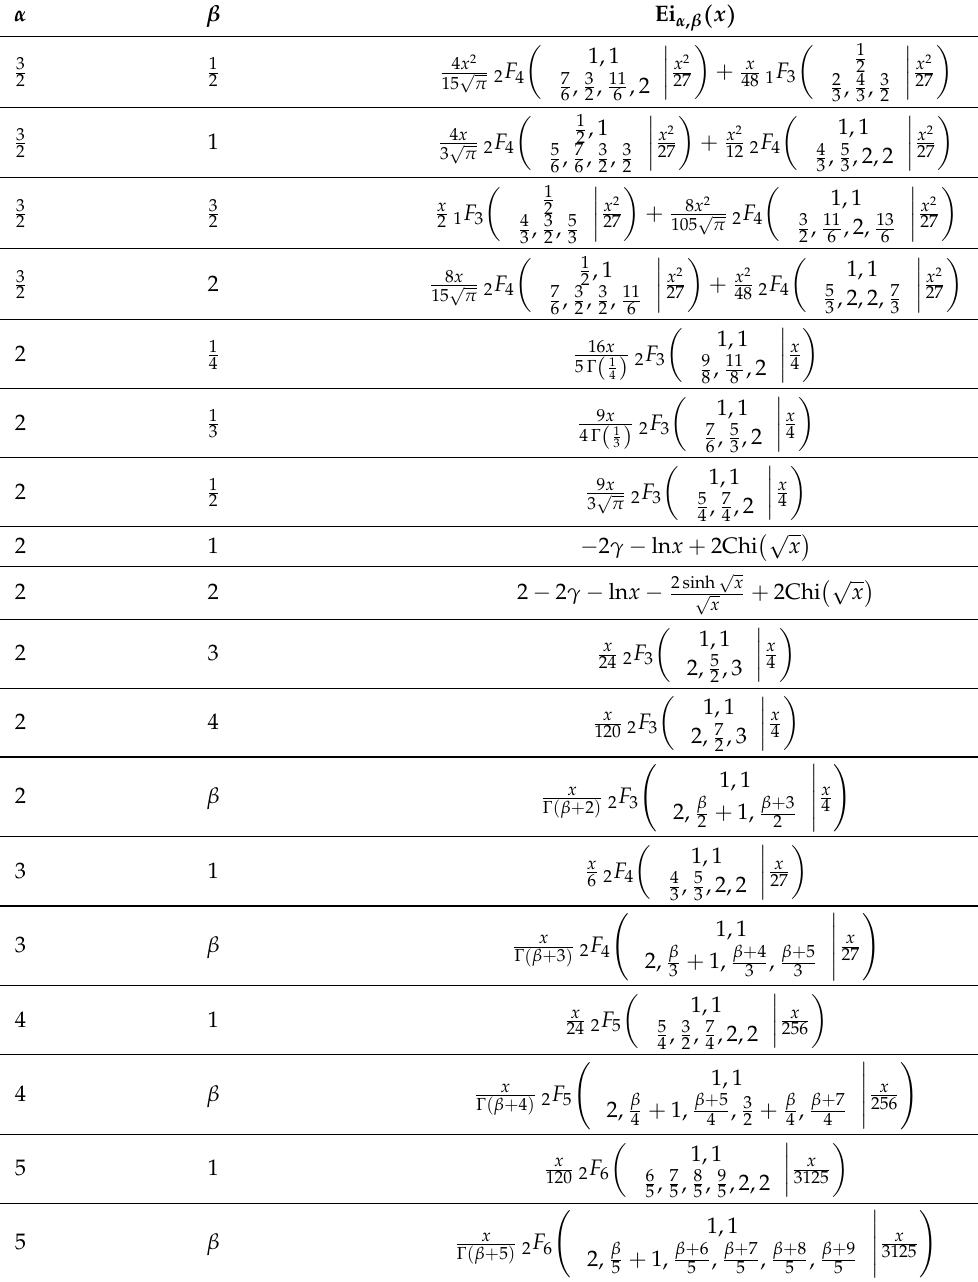
Table 2. The integral Mittag-Leffler functions derived for some values of parameters α and β by using